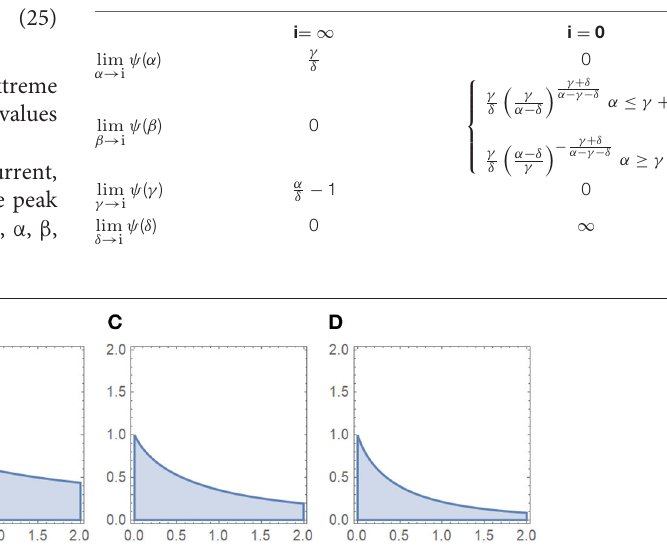
TABLE 1 | Limits for ψ for various extremes.